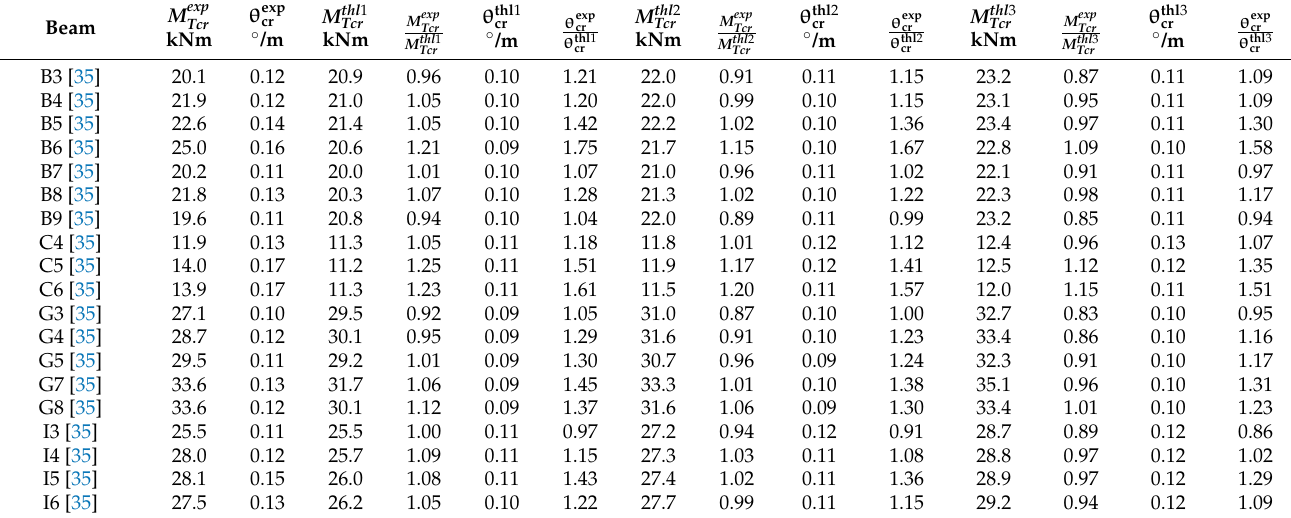
Table A2. Cracking torques and corresponding twists (smeared constitutive laws l 1 to l